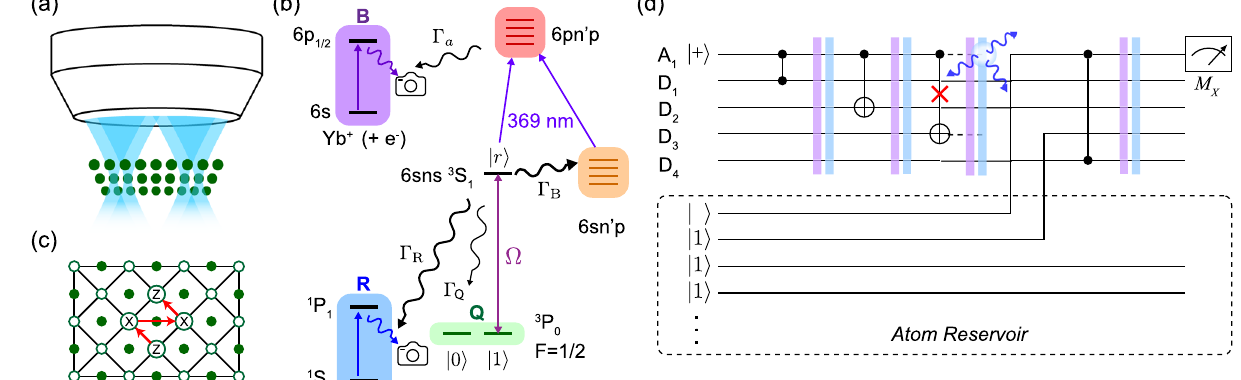
fl uorescence from ground state atoms (subspace R), or ionizing any remaining Rydberg population via autoionization, and collecting fl uorescence on the Yb + transition (subspace B). c A patch of the XZZX surface code studied in this work, showing data qubits (open circles), ancilla qubits ( fi lled circles) and stabilizer operations, performed in the order indicated by the arrows. d Quantum circuit representing a measurement of a stabilizer on data qubits D 1 − D 4 using ancilla A 1 with interleaved erasure conversion steps. Erasure detection is applied after each gate, and erased atoms are replaced from a reservoir as needed using a moveable opticaltweezer.Itisstrictlyonlynecessarytoreplacetheatomthatwasdetectedto have left the subspace, but replacing both protects against the possibility of undetected leakage on the second